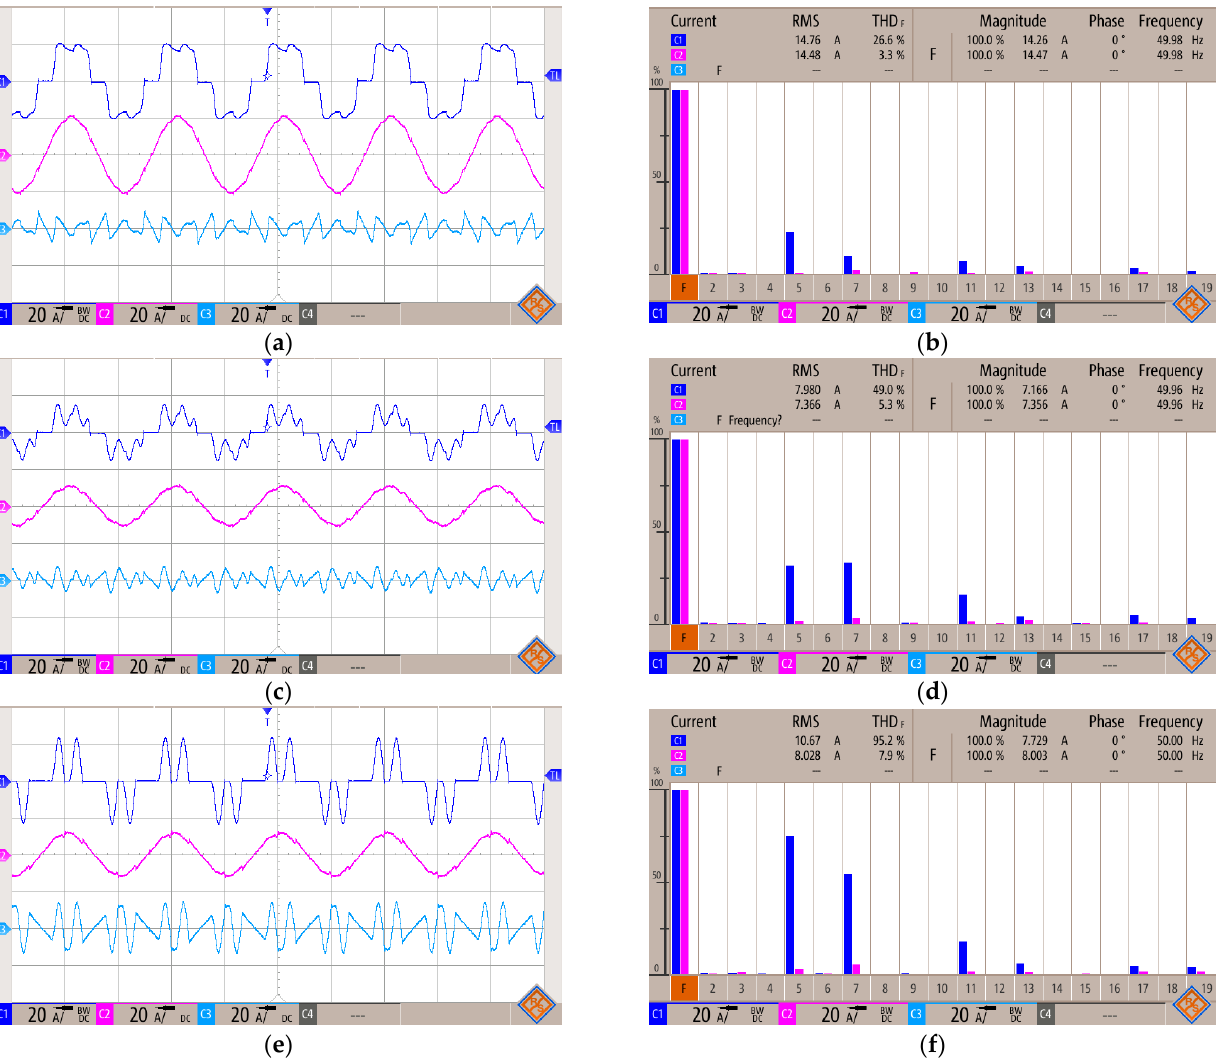
Figure 12. Effectiveness of the harmonics reduction for balanced loads—Diode rectifier with RC circuit and input L filters ensuring different THD levels: Load, grid, and APF filter currents for load with 26.6% THD ( a ), 49.0% THD ( c ), and 95.2% THD ( e ), respectively; Harmonic spectra of load and grid currents for load with 26.6% THD ( b ), 49.0% THD ( d ), and 95.2% THD ( f ), respectively.